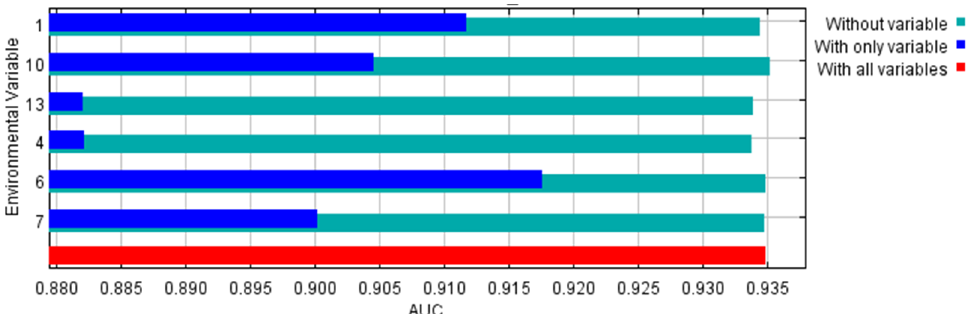
Figure 3. Jackknife test using area under the curve (AUC) on test data for the used environmental variables. 1: Annual mean temperature, 4: Temperature seasonality, 6: Minimum temperature of coldest month, 7: Temperature annual range, 10: Mean temperature of warmest quarter, and 13: Precipitation of wettest month.